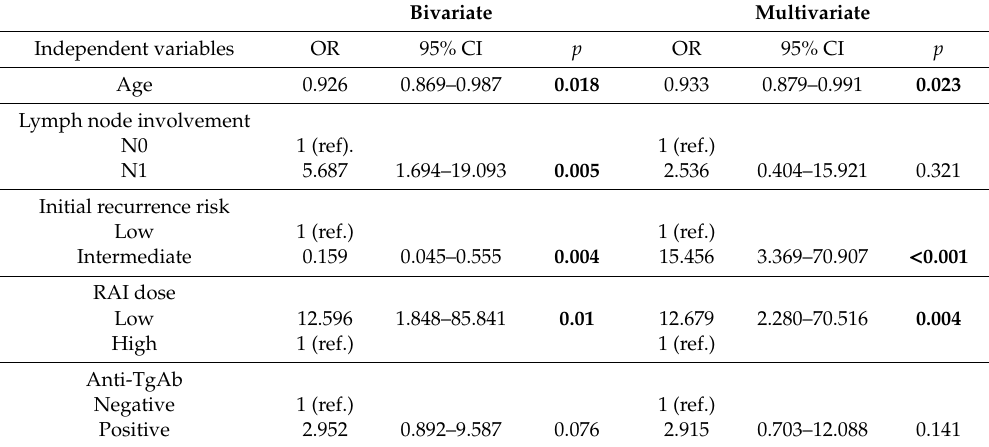
Table3. BivariateandMultivariateLogisticRegressionAnalysis—oddsofrecurrence. Completesample. Bivariate